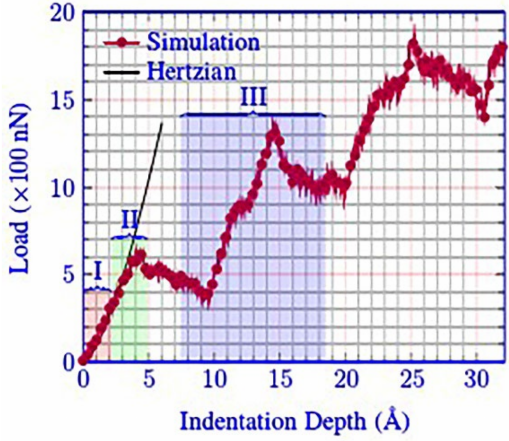
Figure 4. Load–displacement curve of monocrystalline copper.